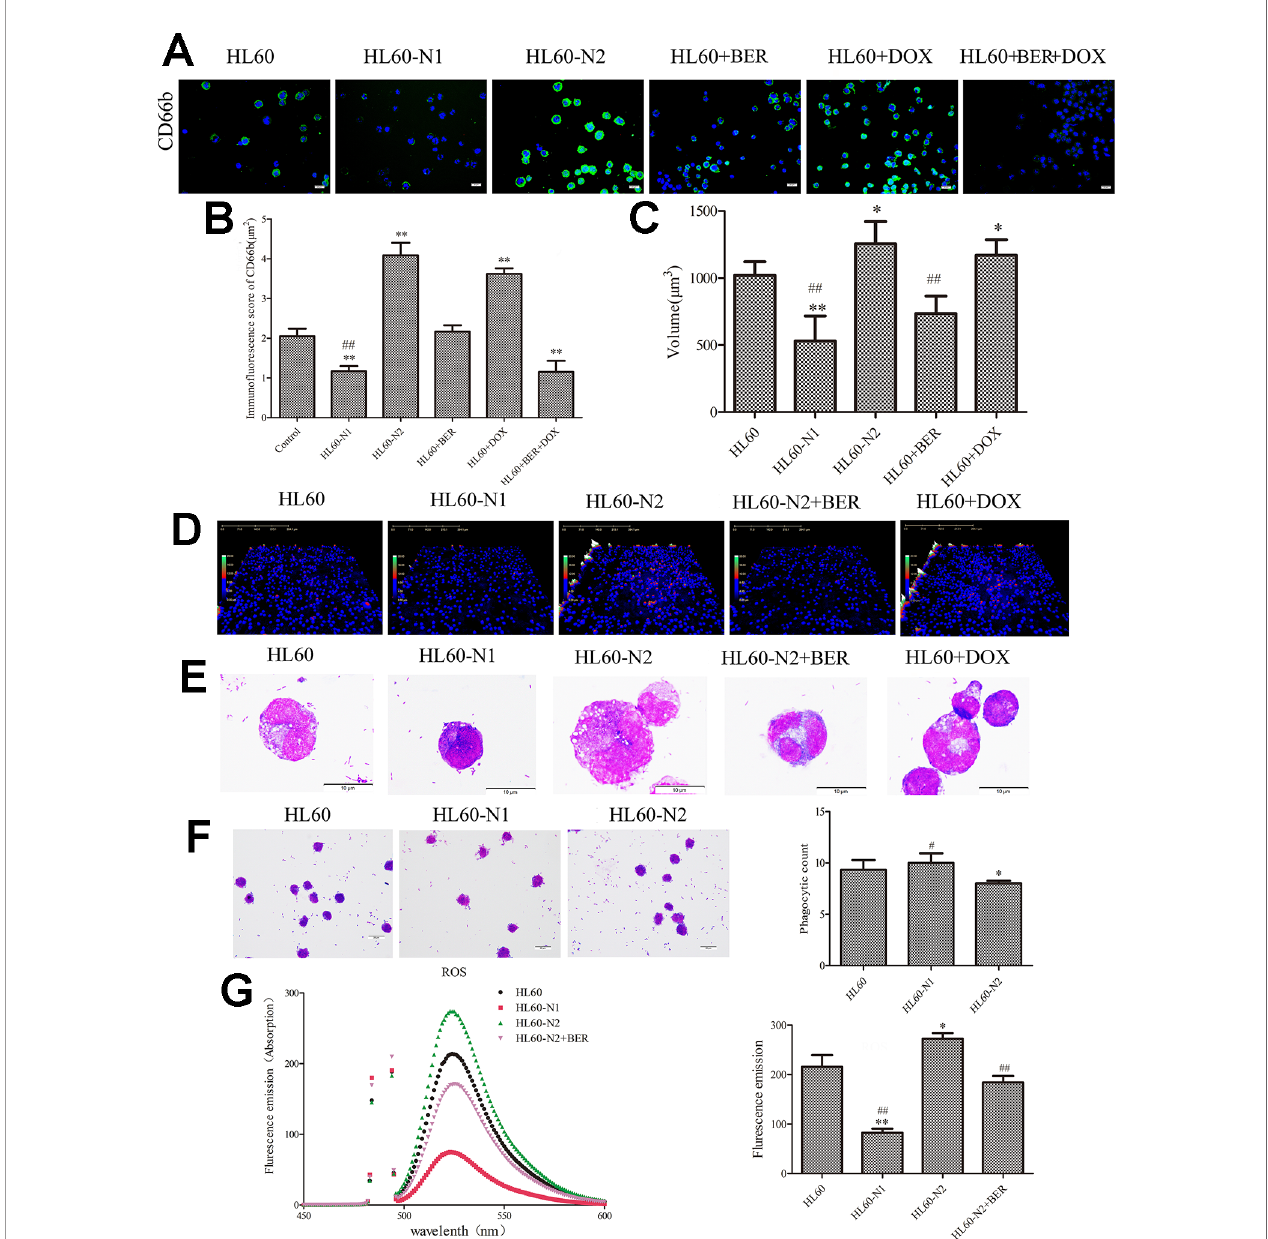
FIGURE 1 | There is a difference between N1-like and N2-like neutrophils. N1-like and N2-like neutrophils were developed from the induced HL-60 cells. (A , B) Neutrophil CD66b expression was analyzed by fl uorescein isothiocyanate (FITC)-conjugated anti-mouse CD66b staining (n = 5, 40×). (C , D) Neutrophil morphological changes analyzed by laser holographic cell imaging and analysis system (n = 5, 20×). (E) Neutrophil morphology indicated by Giemsa staining (n = 5, 100×). (F) Neutrophil phagocytosis detected by Giemsa staining (n = 5, 40×). (G) ROS detected by dichloro-dihydro- fl uorescein diacetate (DCFH-DA) (n = 5). The data present mean ± SD, the experiments were repeated three times, and statistical signi fi cance was determined by a t-test. *P < 0.05, **P < 0.01 vs . HL60; # P < 0.05, ## P < 0.01 vs . HL60-N2. DOX, doxorubicin; BER,